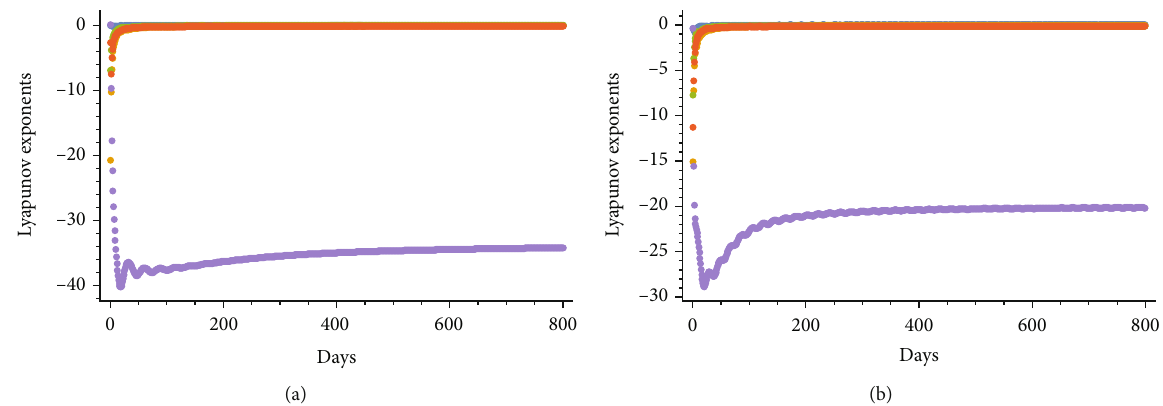
= 0 : 055 ; (b) γ = 0 : 095 and other default parameter values and with assumed initial 2 2